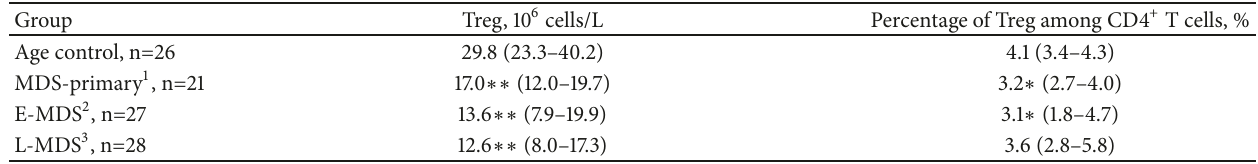
Table 4: The absolute number and percentage of regulatory T cells in the peripheral blood of patients with MDS and age-matched healthy donors. Group Treg, 10 6 cells/L Percentage of Treg among CD4 + T cells, % Age control,